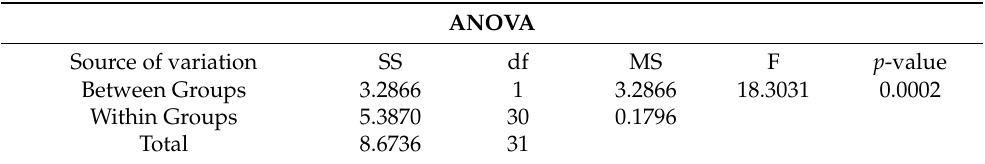
Table 3. Analysis of Variance (ANOVA) result of four Miscanthus genotypes (PMS-7, PMS-164, PMS- 285, PMS-347) based on their drought stress index of four photosynthetic parameters (photosynthetic rate, stomatal conductance, transpiration rate, and chlorophyll fluorescence) under slight drought stress † of Hokkaido University (HU) precise-comparison and Brigham Young University (BYU) screening